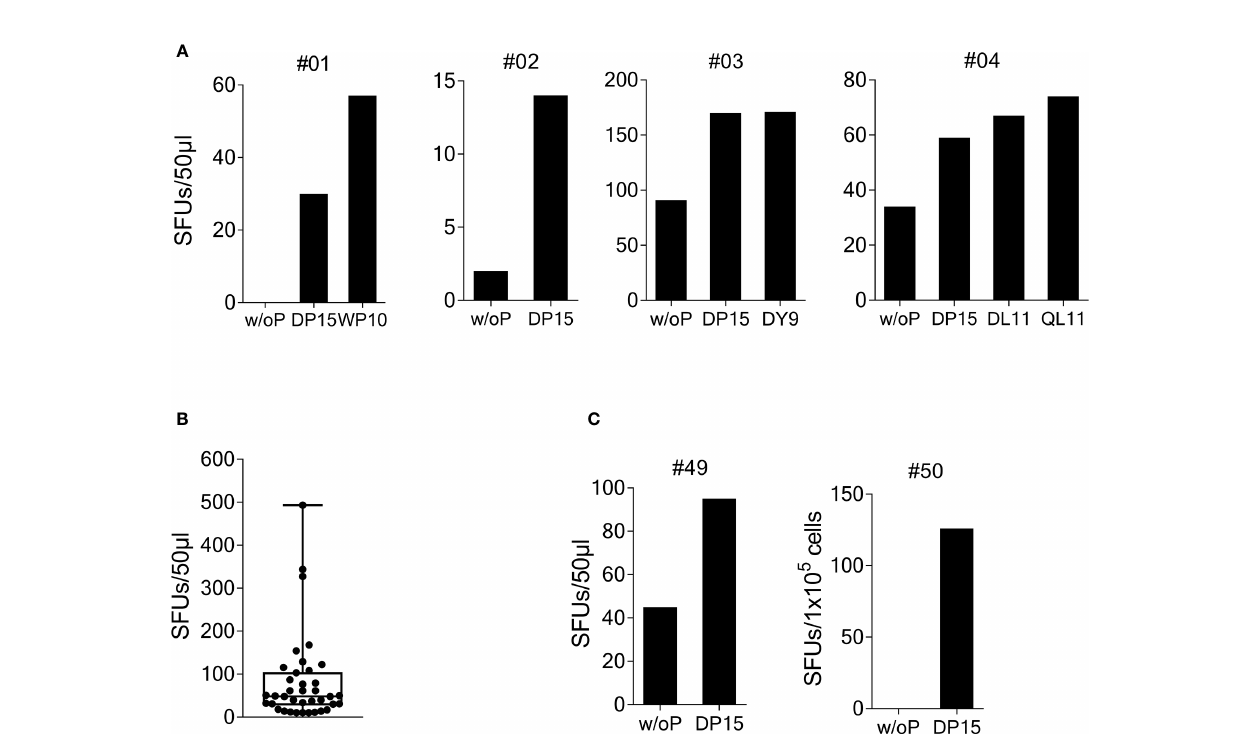
FIGURE 1 | Recognition of SARS-CoV-2/OC43 homologous peptides in g -IFN ELISpot assays. PBMCs were stimulated with SCoV-DP15 and IL-2 and after 9 to 14 days outgrowing cells were tested for recognition of SCoV-DP15 or shorter peptides within SCoV-DP15 at a fi nal peptide concentration of 20 µg/ml. Peptide-stimulated T-cell lines without addition of peptide in the ELISpot served as negative controls to assess unspeci fi c background reactions. Shown are SFUs per 50µl of T-cell suspensions in g -IFN ELISpot assays. (A) Recognition of SCoV-DP15 or of truncated peptides by DP-15-stimulated T-cell lines from four healthy SARS-CoV-2 seronegative subjects (B) Magnitude of SCoV-DP15-speci fi c response of DP-15-stimulated T-cell lines from healthy (n=3) and HIV-1-infected (n=35) CoV-DP15-responders. Shown are SFUs after subtraction of background with indication of median, range and 1 st and 3 rd quartile. (C) SCoV-DP15-speci fi c g -IFN responses of SARS-CoV-2 convalescent patient #49 and #50. 50µl of T-cells were used of donor #49, 1x10 5 cells/well were used for donor #50. w/o. P, without peptide; SFUs, Spot Forming Units, SCoV-DP15, DLSPRWYFYYLGTGP; SCoV-DL11, DLSPRWYFYYL; OC43-QL11, QLLPRWYFYYL; CoV-WP10, WYFYYLGTGP; SCoV-DY9,